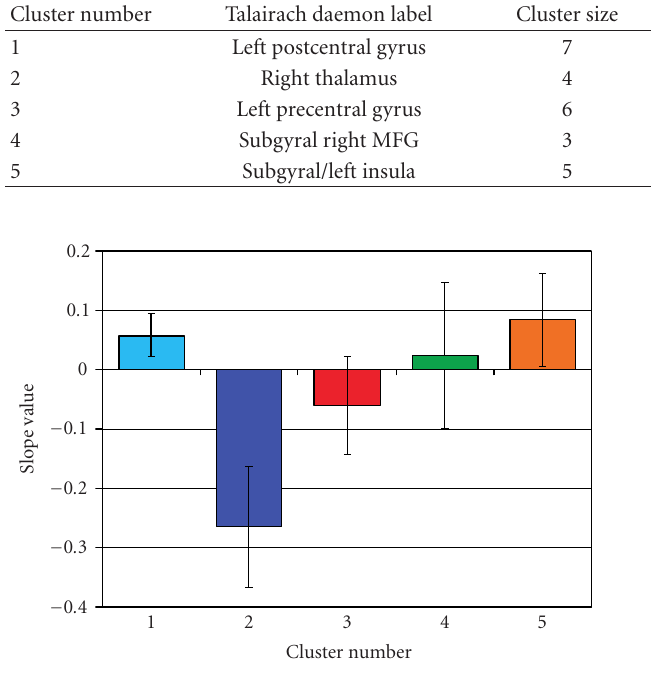
Figure 4: Average slope values for clusters with slopes significantly di ff erent from one. A total of 5 clusters (color-coded for clarity) sur- vived and had average slope values less than 1 and greater than − 1. These slope values are the result of greater between-task BOLD sig- nal change in the cohort of young adults than older adults.